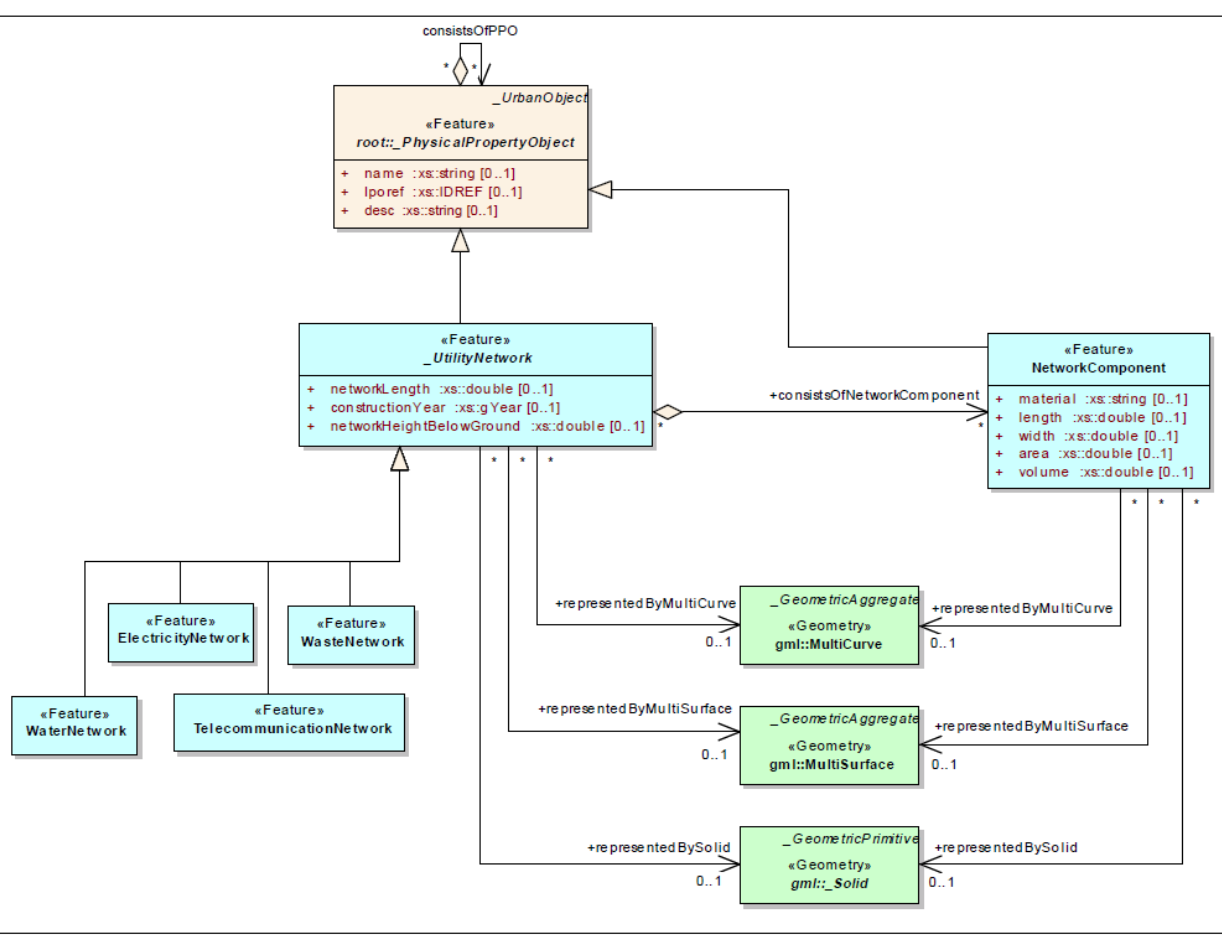
Figure 20. Example of a tunnel model consists of structural components and a space.